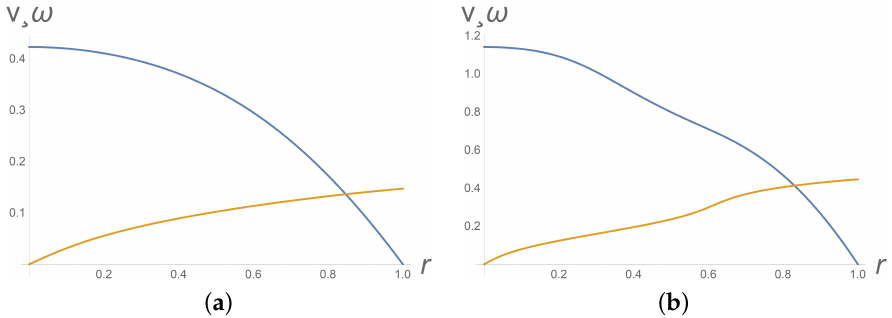
Figure 2. From top to bottom, profiles of the dimensionless velocity v ( y ) and dimensionless micro- spin ω ( y ) on the upper half-layer 0 < y < 1 at dimensionless time t = 10 for dimensionless pressure gradient ( a ) Π = 0.85 and ( b ) Π = 2.85. Gradient banding development is observed at high pressure gradients ( b ).